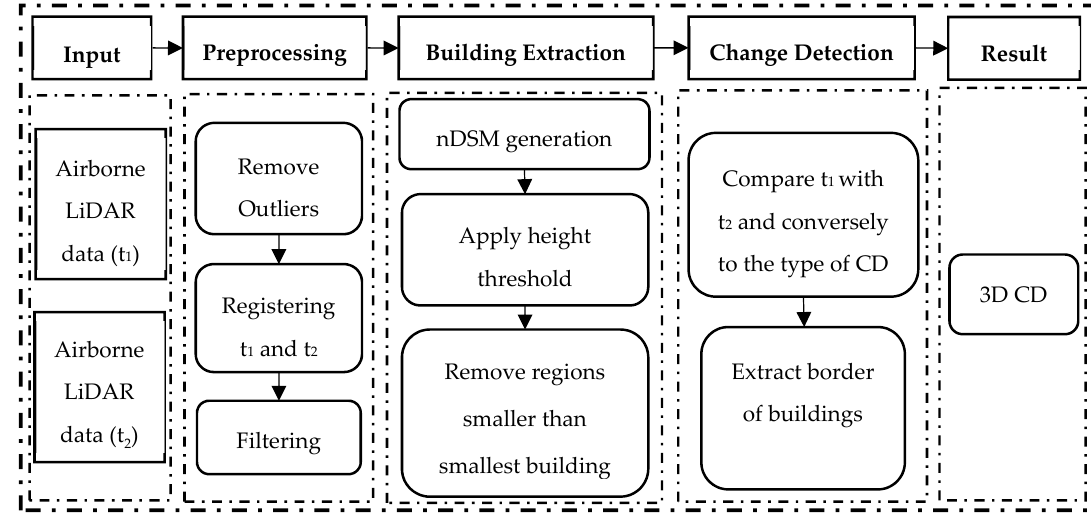
Figure 3. Flowchart of the proposed algorithm.